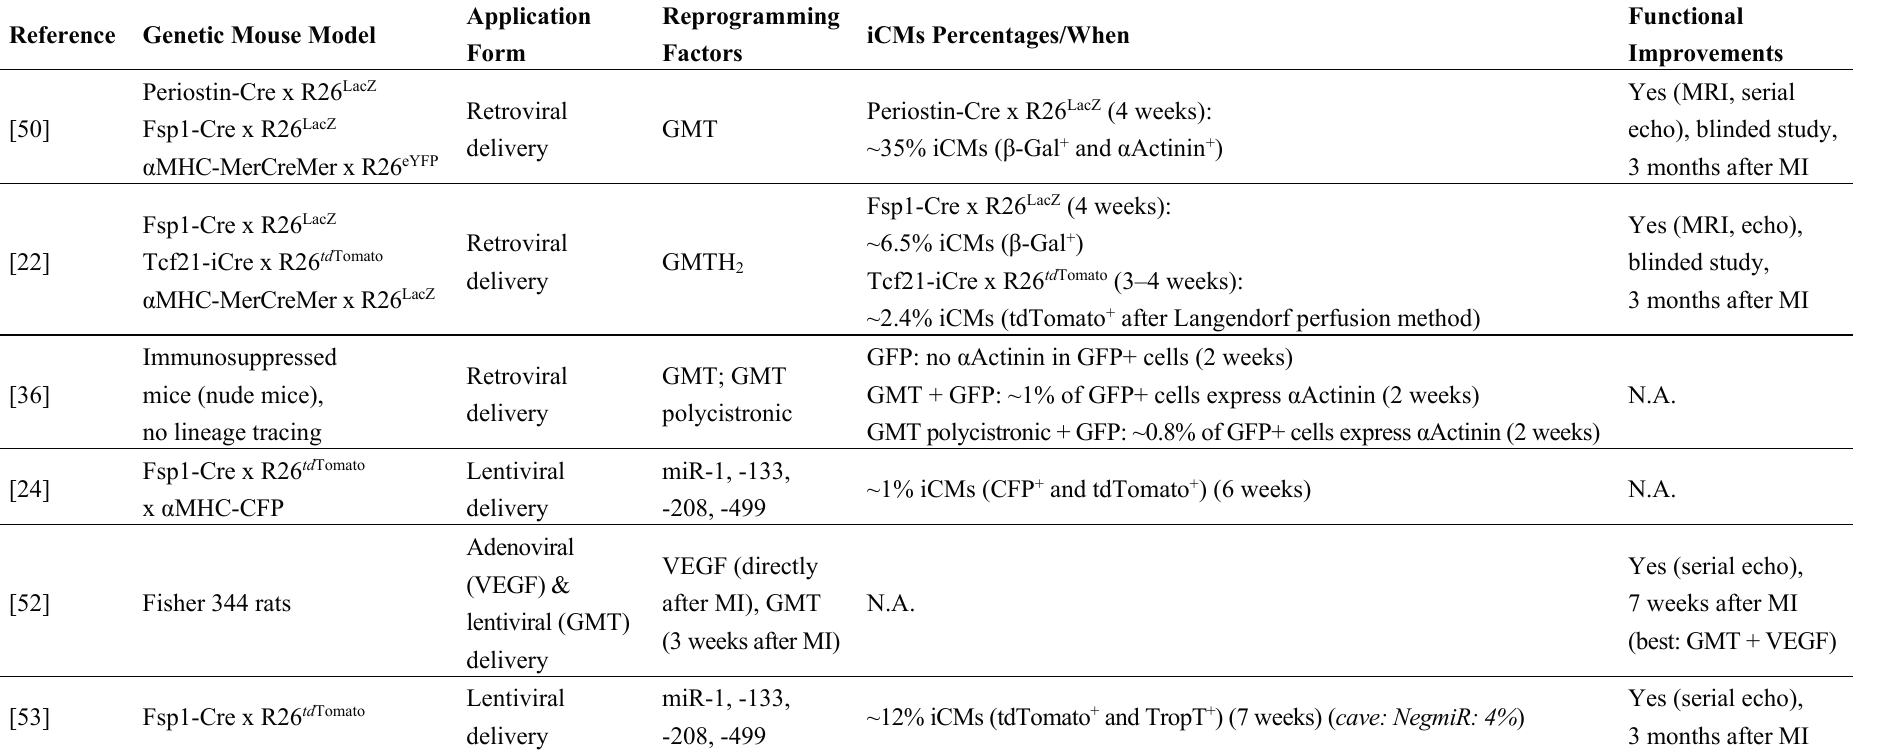
Table 3. Direct cardiac reprogramming in vivo (rodent infarction by LCD